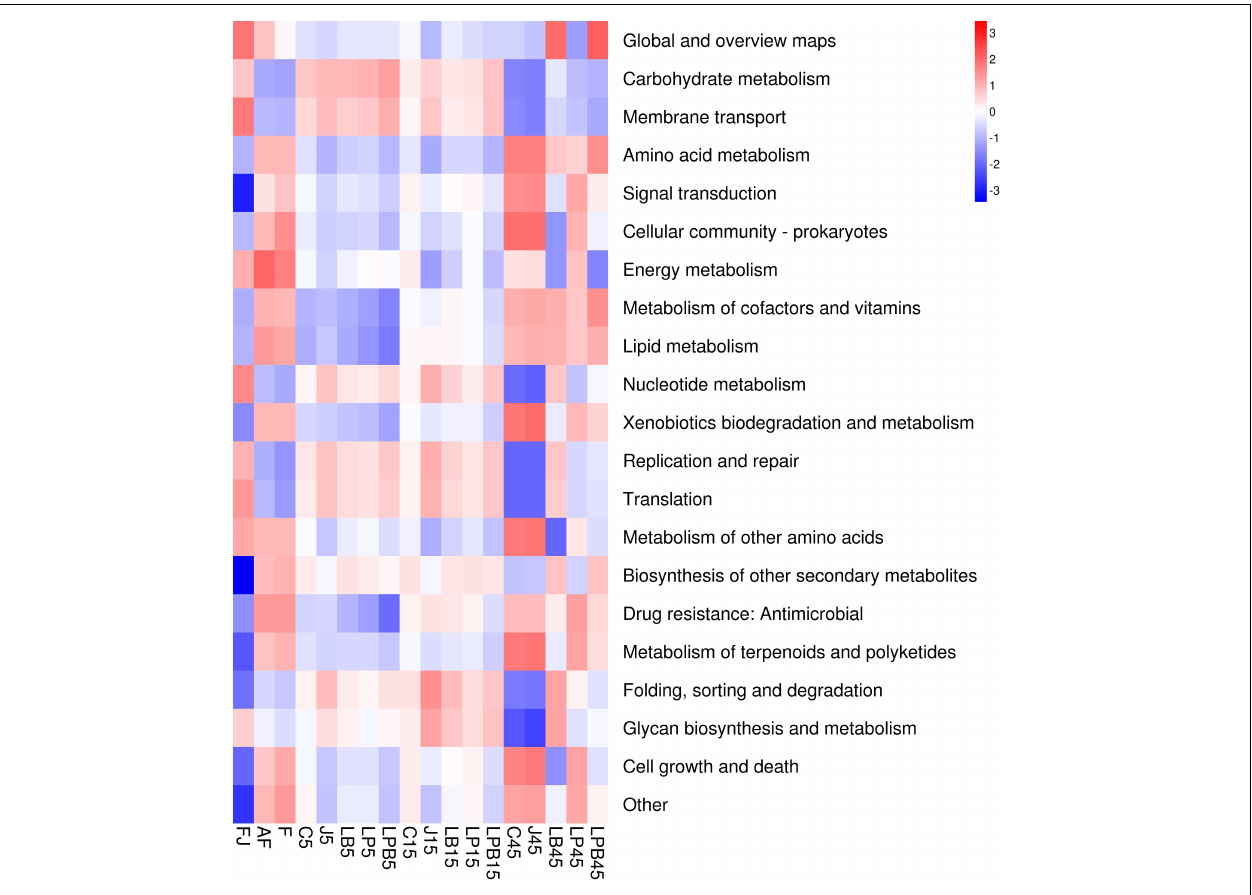
FIGURE 7 | Heatmap of KEGG pathway, the second level of the predicted functional shift is shown with respect to the fermentation processes and inoculant treatments. AF, fresh alfalfa; FJ, pre-fermented juice; F, mixture; C, control; J, pre-fermented juice-treated silage; LP, L. plantarum -treated silage; LB, L. buchneri - treated silage; LPB, L. plantarum + L. buchneri- treated